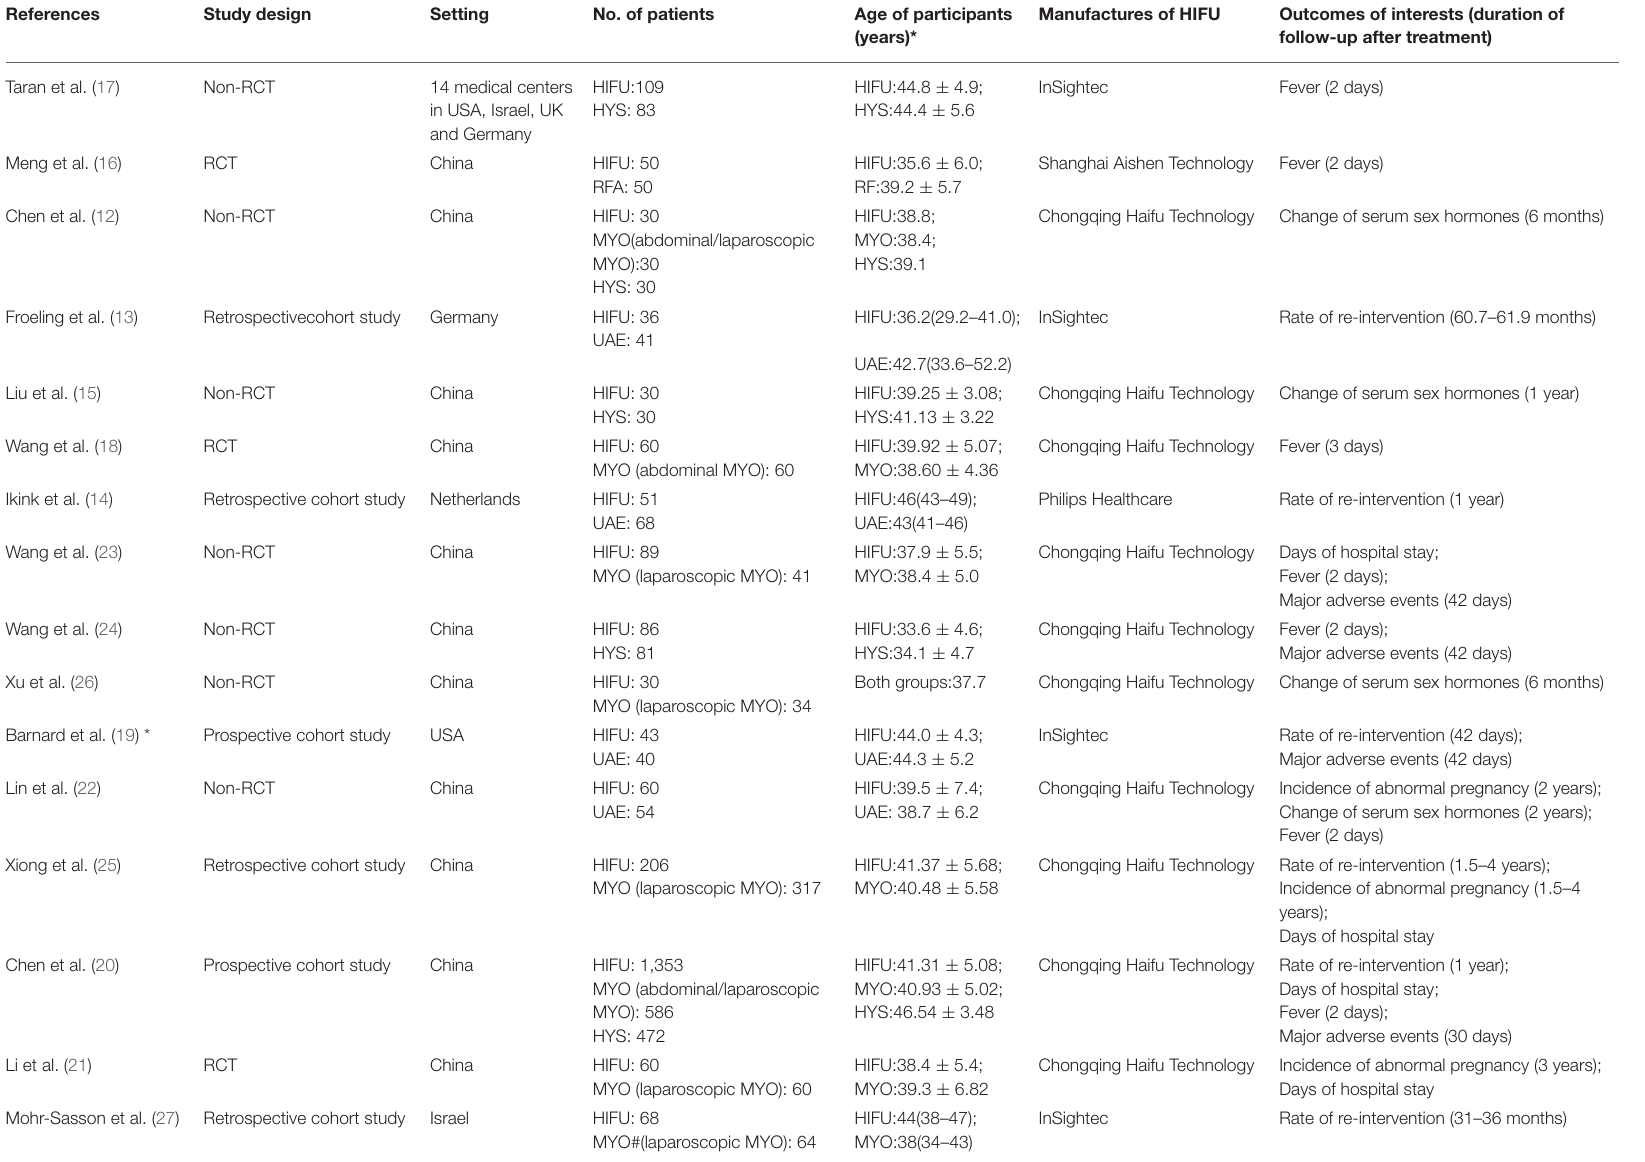
TABLE 1 | Characteristics of included